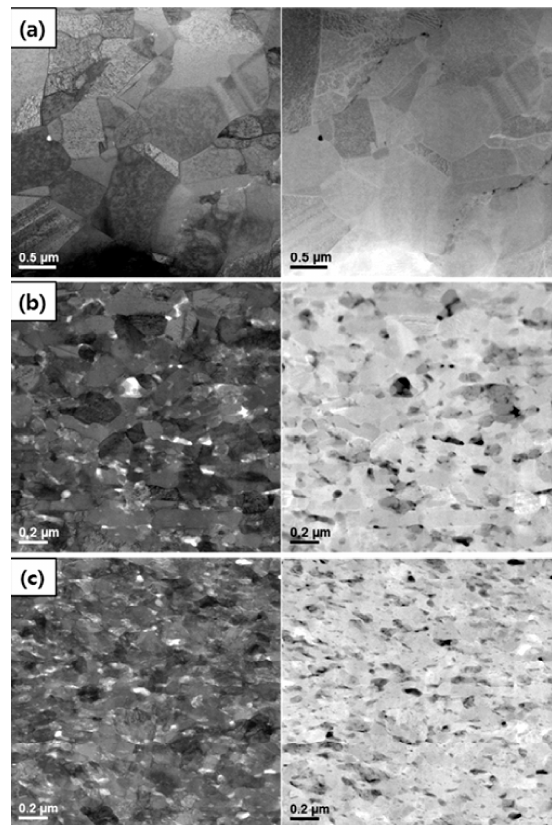
Figure 29. STEM (scanning transmission electron microscope) images of Cu and CNT-Cu nanocomposites fabricated by high pressure torsion (HPT): ( a ) Pure Cu, ( b ) 5 vol % CNT-Cu, and ( c ) 10 vol % CNT-Cu nanocomposites. The left images are provided by bright-field mode, and the right ones by high-angle annular dark-field mode [41]. (Reproduced with permission from [41], Springer, 2013.